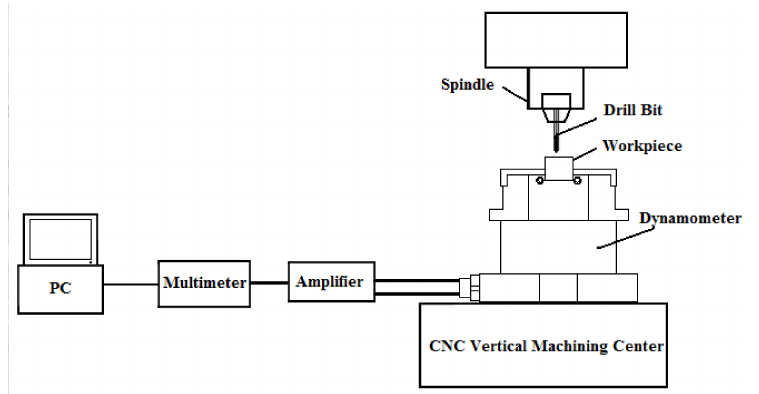
Figure 2. Schematic of the experiment setup for measuring the thrust